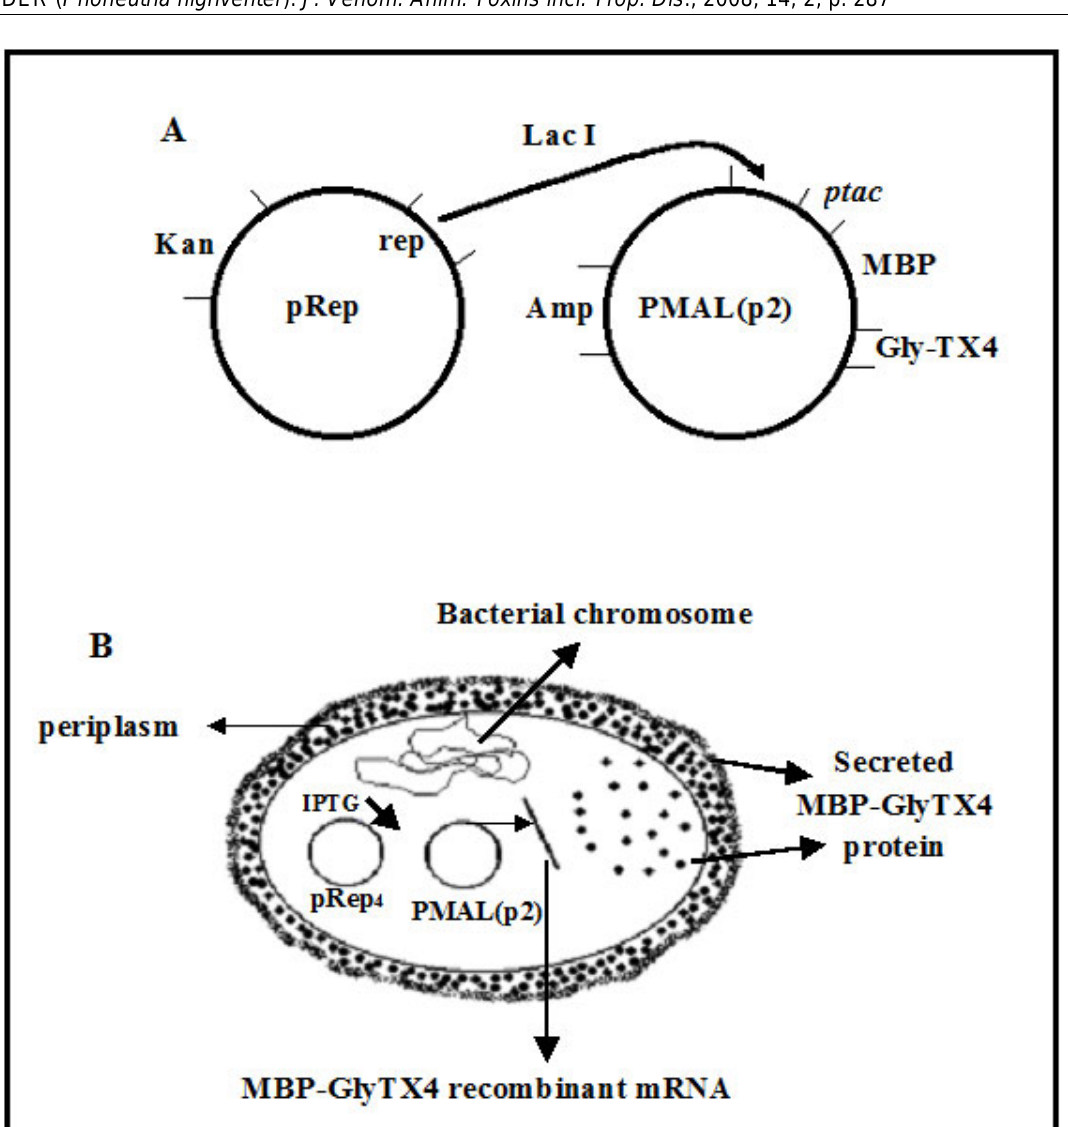
Figure 2. Diagram of molecular cloning (A) and expression (B) of the MBP-GlyTX4 fusion protein. The recombinant pMAL-2MBP-GlyTX4 and the lac repressor (pREP) plasmid were used for cotransformation of the Escherichia coli M15 strain. The recombinant MBP-GlyTX4 protein was induced by IPTG and targeted to bacterial